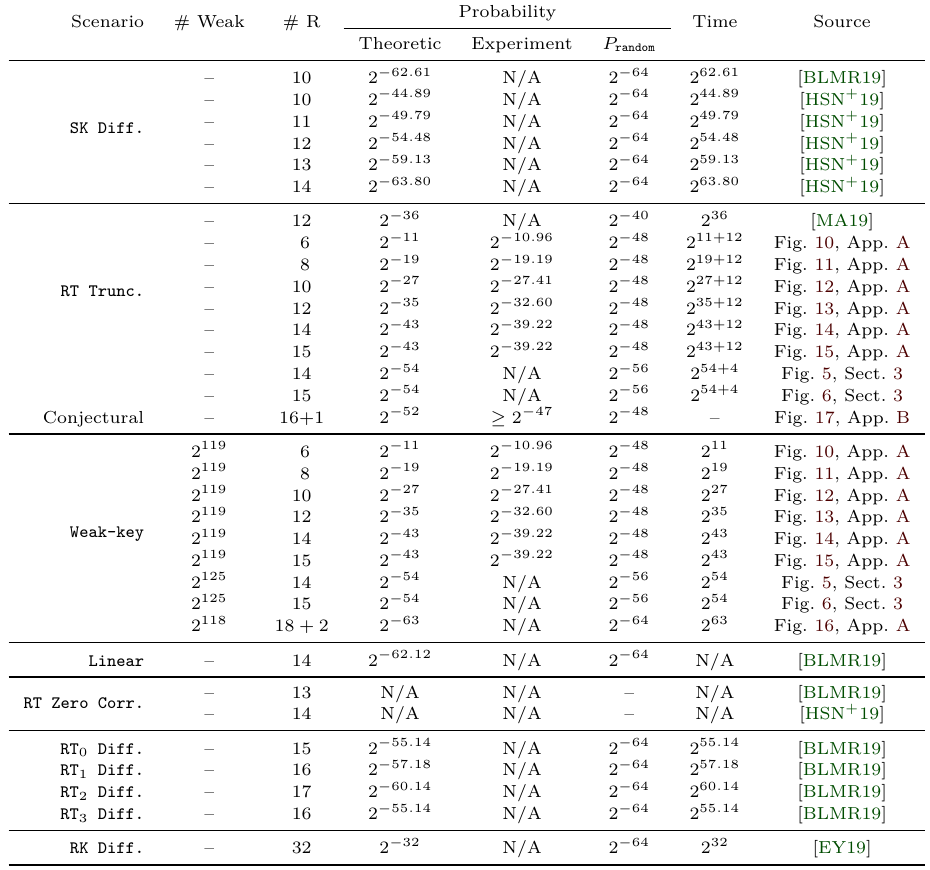
Table 1: Distinguishers for round-reduced CRAFT , where SK , RK , RT stand for single-key, related-key, and related-tweak, respectively. In the weak-key and non-weak-key scenarios, the # Weak column counts the number of weak keys of the underlying distinguisher, and # R tells the number of rounds covered by the distinguisher. Note that due to the degrees of freedom provided by the tweak in differential attacks, we can collect up to 2 128 data. Scenario